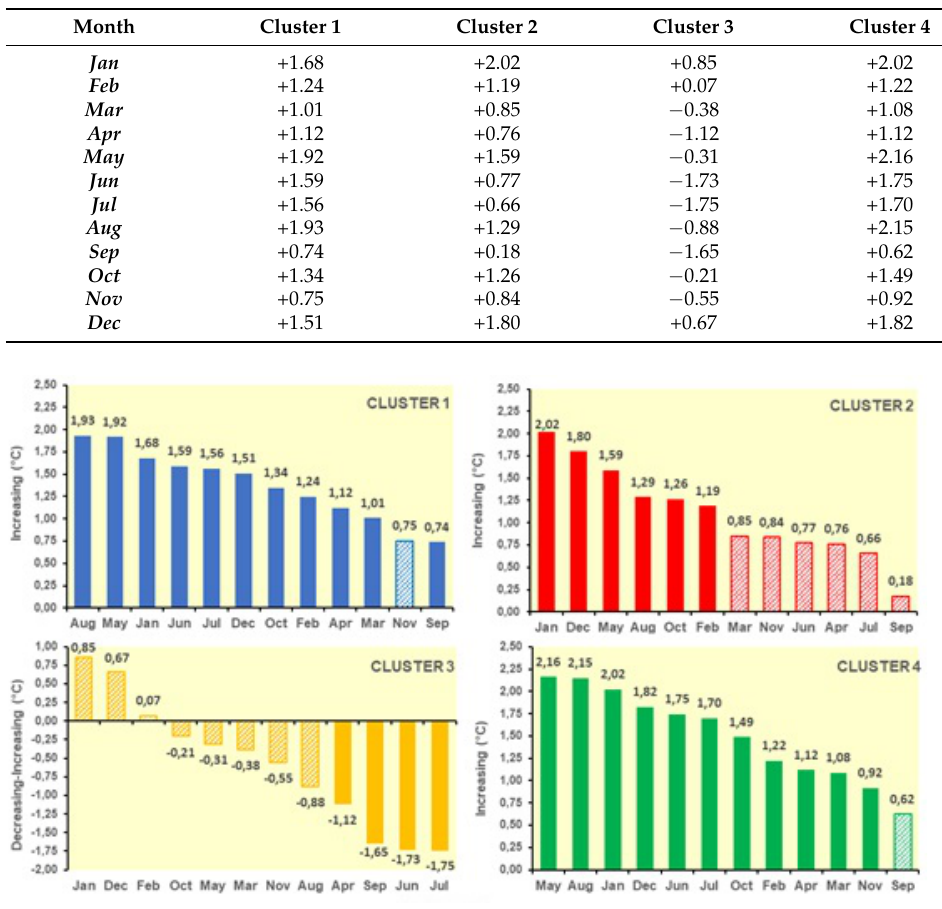
Figure 3. Monthly temperature increases from 1925 to 2015, for each Cluster: the light bar indicates the absence of significant trends.